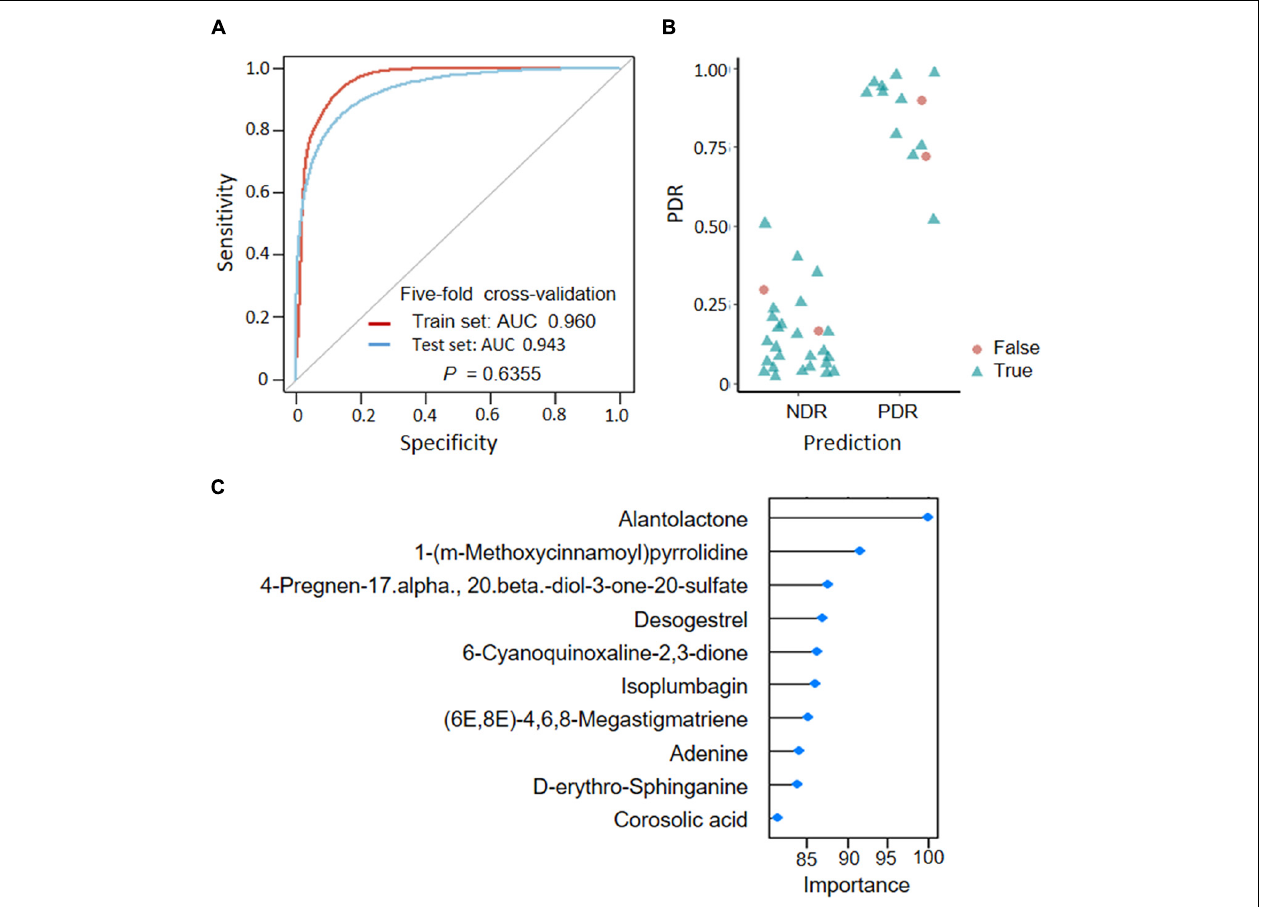
FIGURE 5 | Predicting proliferative diabetic retinopathy based on fecal metabolites. (A) Classification performance as shown by AUC. (B) Predicted probabilities for each sample. (C) TOP10 strongest discriminant metabolites in the classifier. PDR, proliferative diabetic retinopathy; NDR, diabetic patients without retinopathy; AUC, area under